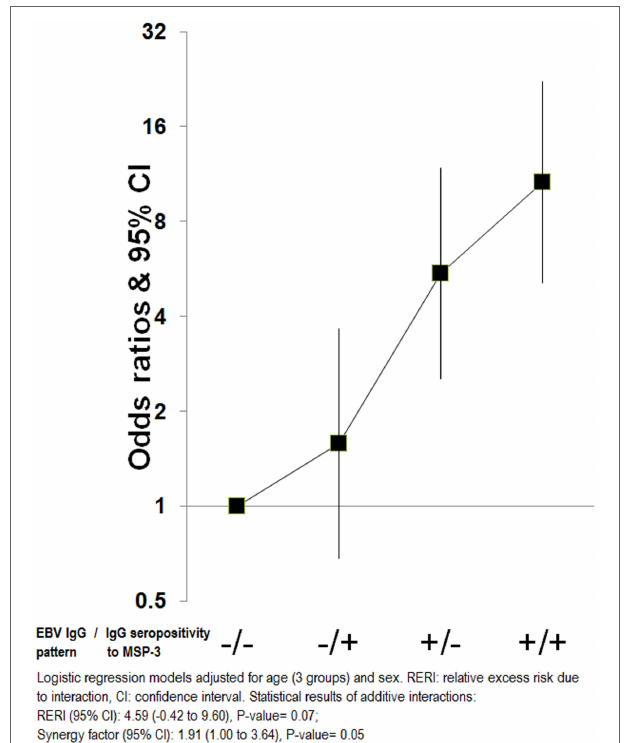
FigUre 5 | Additive interactions for endemic Burkitt lymphoma between “Epstein–Barr virus (EBV) IgG pattern” and IgG to merozoite surface protein 3